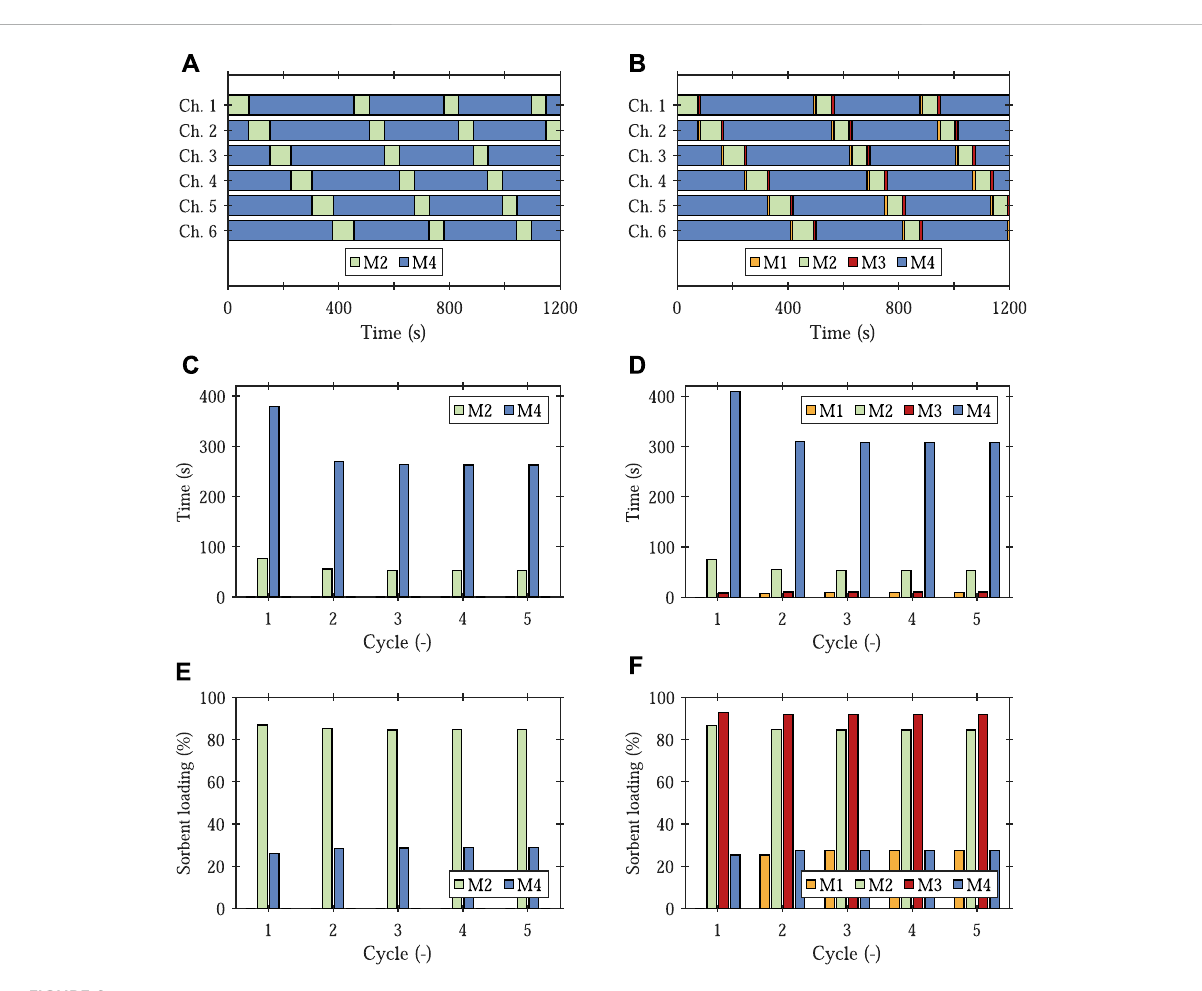
FIGURE 9 MATLABSimulink resultsforthepilotplantbasecasesimulationinsinglestagecon fi guration (A,C,E) andserialcon fi guration (B,D,F) .Theswitch from M2 to M4 (single stage con fi guration) or M3 (serial con fi guration), respectively, is triggered as soon as y {CO chamber. The switch from M3 to M4 in serial con fi guration occurs when the CO 2 volume fraction to the subsequent chamber is y {CO Operating schedule for all six reaction chambers, (C,D) Time span of each operation mode for the fi rst fi ve cycles in chamber 1, (E,F) Relative sorbent loading at the end of each operation mode for the fi rst fi ve cycles in chamber